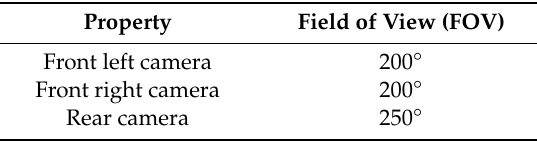
Table 3. Field of views of stereo camera